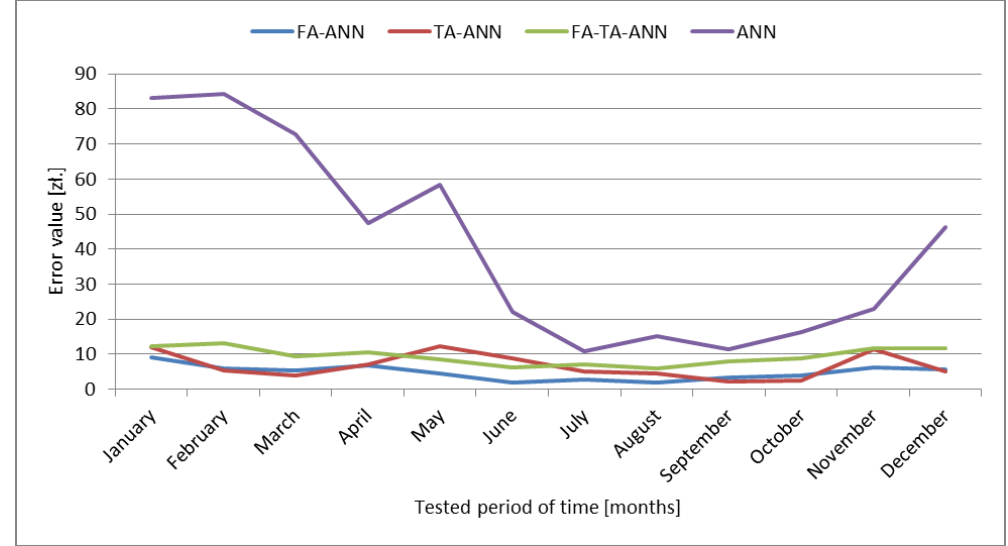
Figure 7. Comparison of E max values per month using ANN-based models over one year (2010) for BPH Bank SA.